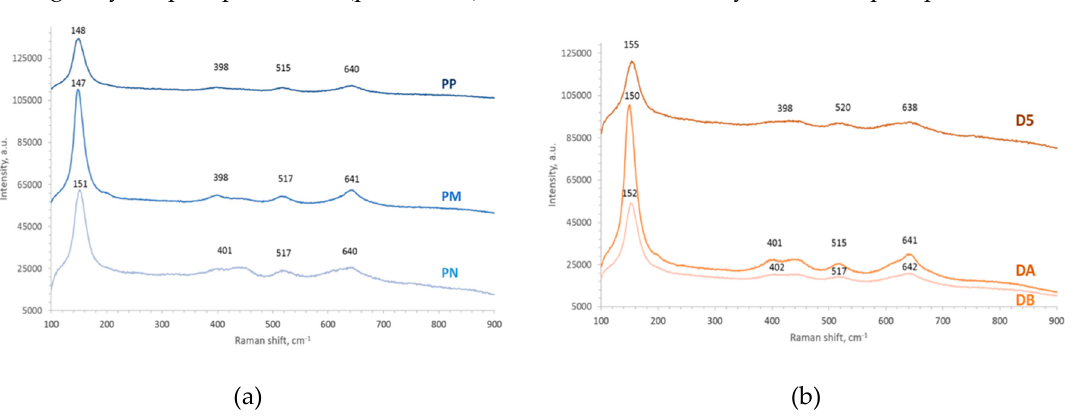
Figure 3. Raman spectra ( λ = 514.5 nm) on free surfaces of PEO single ( a ) and double layers ( b ). All indexed peaks are assigned to anatase.